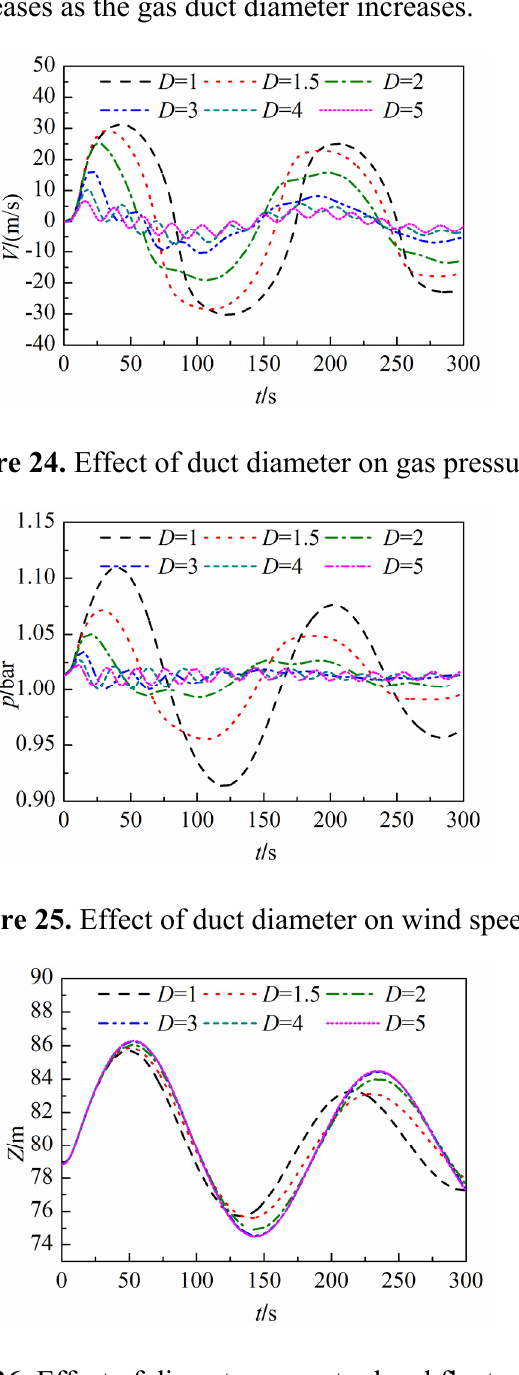
Figure 26. Effect of diameter on water level